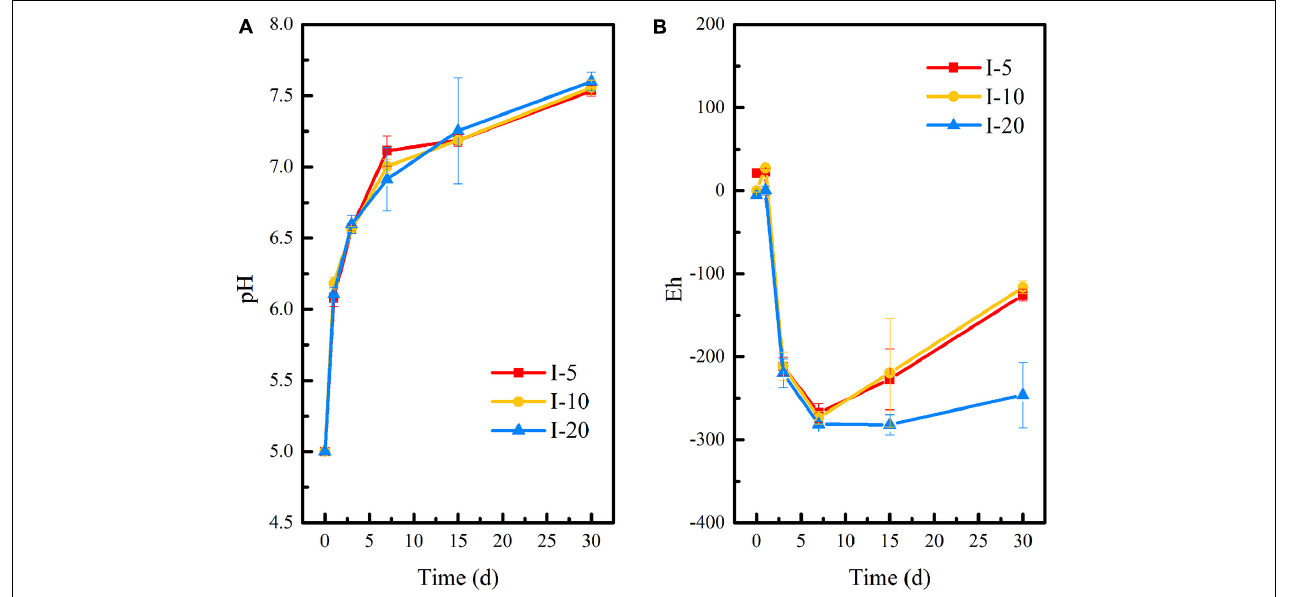
FIGURE 7 | Changes of (A) pH and (B) Eh during the microbial stabilization process of SRB-PSB under different inoculation volumes.